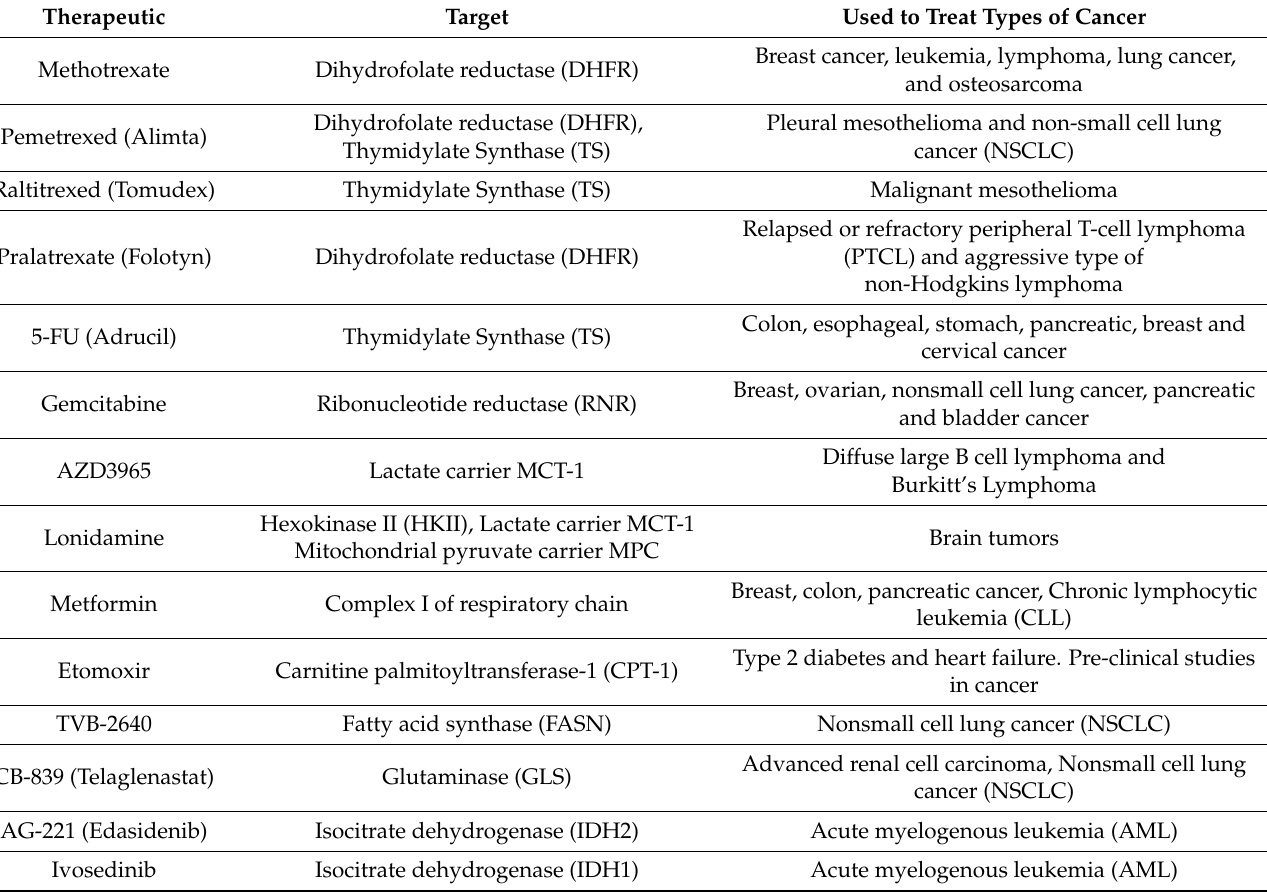
Table 2. Metabolic inhibitors, which are currently being used to treat cancer or participated in clinical trials. Therapeutic Target Used to Treat Types of Cancer Breast cancer, leukemia, lymphoma, lung cancer, and